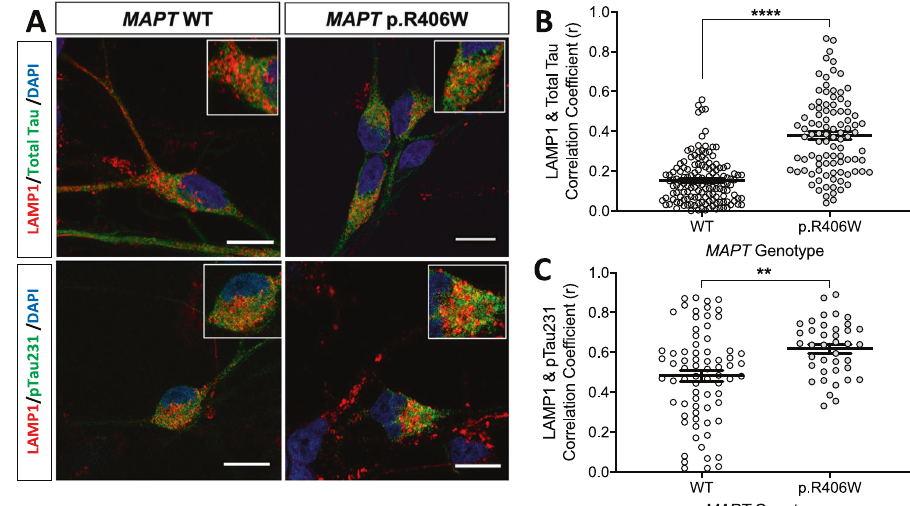
Fig. 6 Colocalization of tau and phospho-tau with LAMP1-positive vesicles. iPSC from a MAPT p.R406W mutation carrier and CRISPR/Cas9- corrected control (wild-type (WT)) were differentiated into cortical neurons and cultured for 6 weeks prior to analysis. A Representative confocal images showing colocalization of LAMP1 (red) and total tau (Tau5; green) or ptau (AT180; green) in the MAPT p.R406W neurons compared with isogenic controls. Scale bar, 10 microns. B Colocalization of LAMP1 and total tau in tau-positive soma (WT, n = 146 cells; p.R406W, n = 95 cells) C Colocalization of LAMP1 and ptau in ptau-positive soma (WT, n = 73 cells; p.R406W, n = 39 cells). Graphs represent mean ± SEM. Signi fi cance was determined using an unpaired, t -test. ** p < 0.01; **** p < 0.0001.